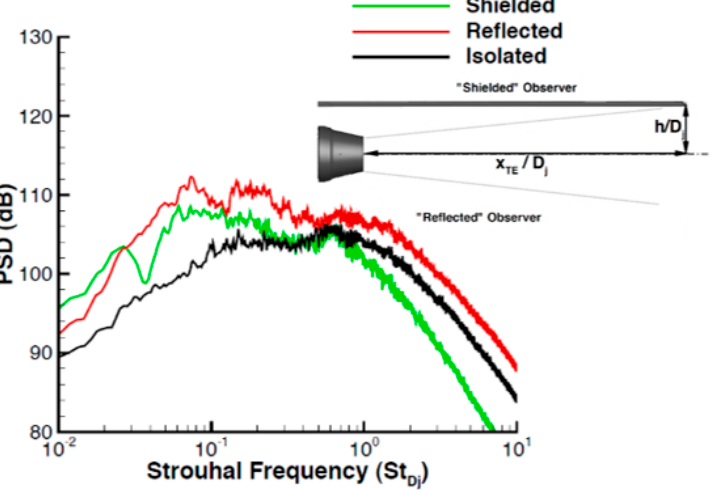
Figure 6. Jet noise spectral measurements for a supersonic ideally expanded circular jet (Ref. [33]).